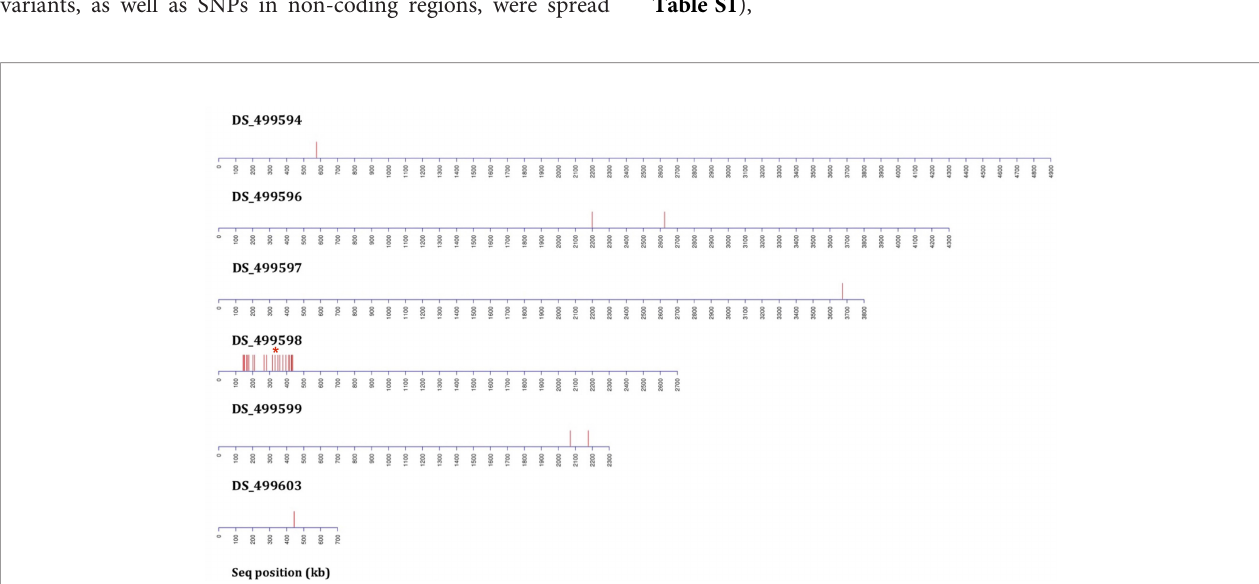
Table S1 . Further bioinformatic analysis identi fi ed three